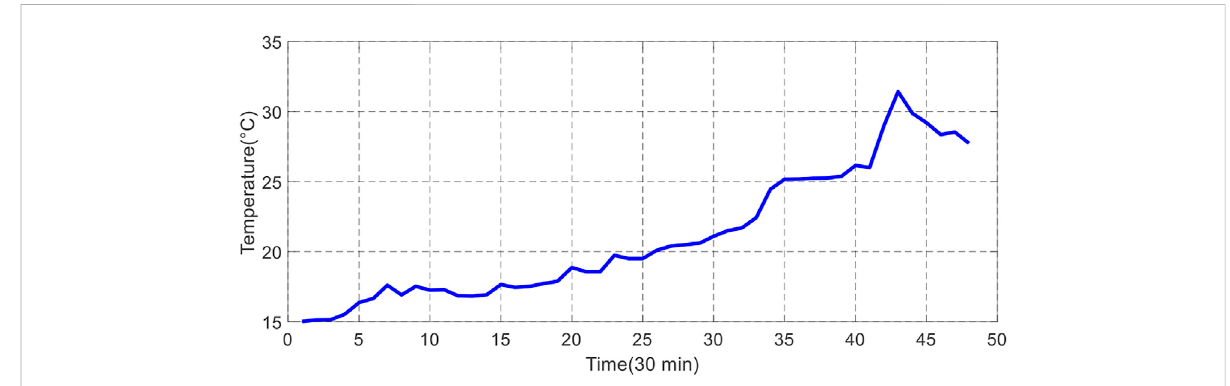
FIGURE 6 Temperature pro fi le (1 day).